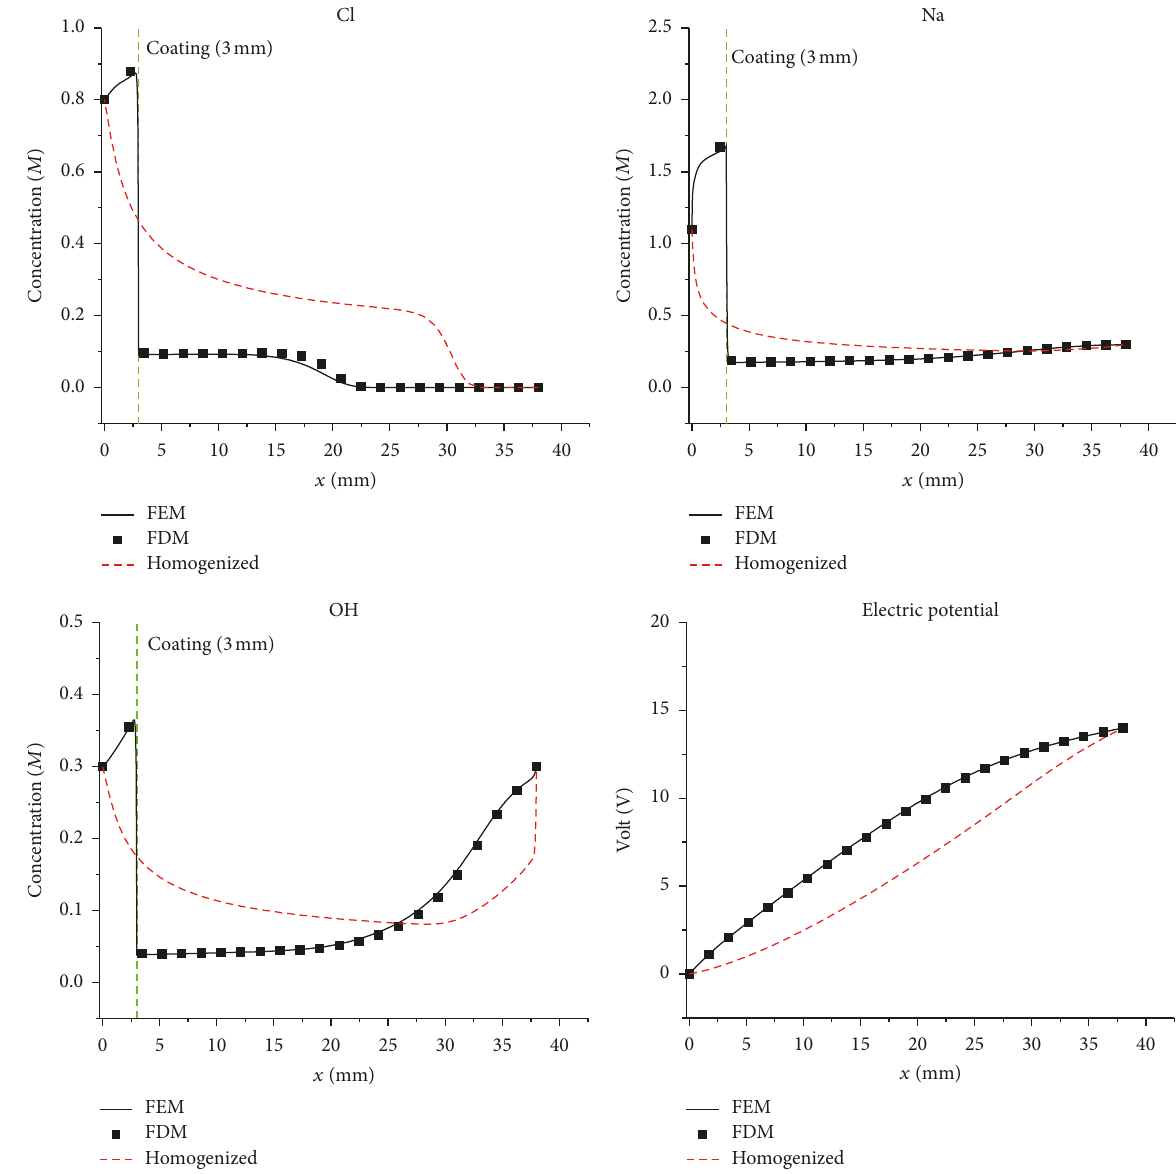
Figure 5: Ionic and electric potential profiles after 24-hour migration test ( 𝐷